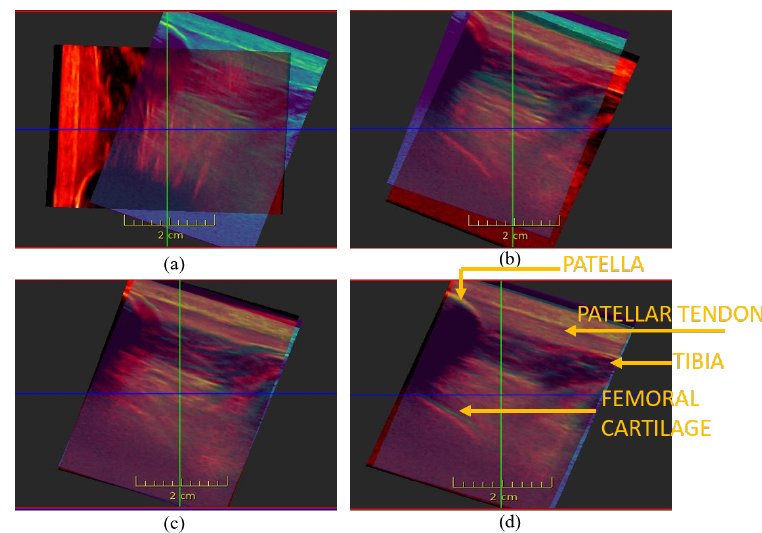
Figure 6. A sagittal slice is extracted from a 3D US volume and output at four different stages of the method is shown along with the ground truth. Algorithm’s output is shown in red, and the ground truth slice is shown in blue. From top-left: ( a ) initial orientation; ( b ) output after pre-initialization; ( c ) output after applying distance transforms; ( d ) final output after implementing LC 2 registration.